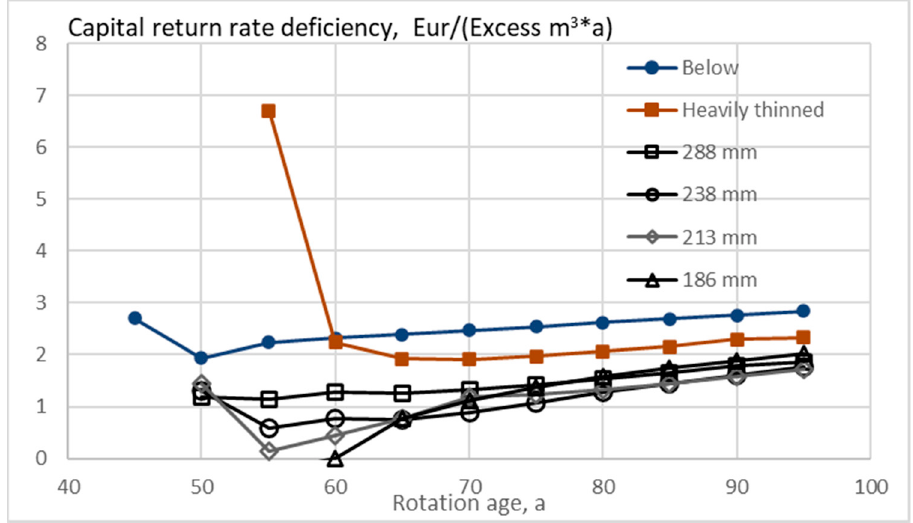
Figure 13. The deficiency of the expected value of capital return rate in terms of Euros per excess volume and year. The deficiency is plotted for six different treatment schedules and any rotation age. Negative values are omitted from the figure.